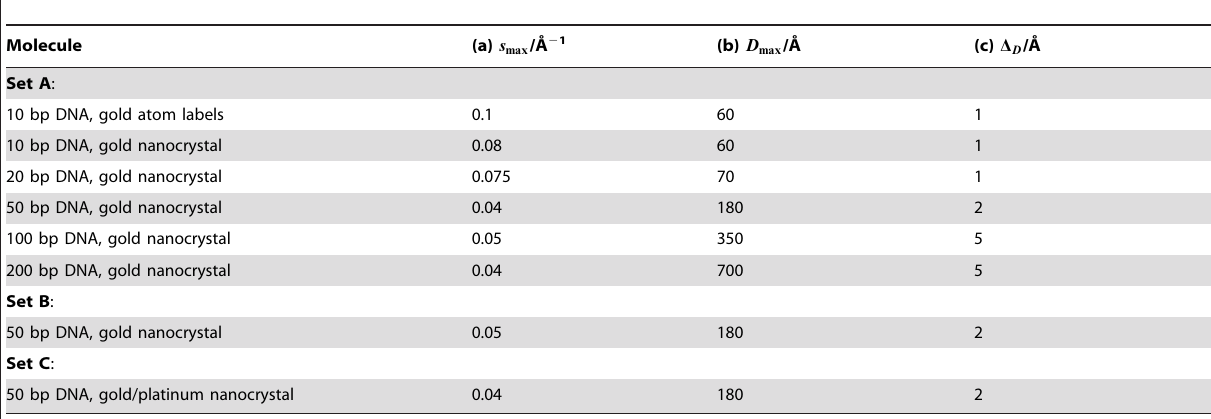
Table 4. Parameters for simulations.